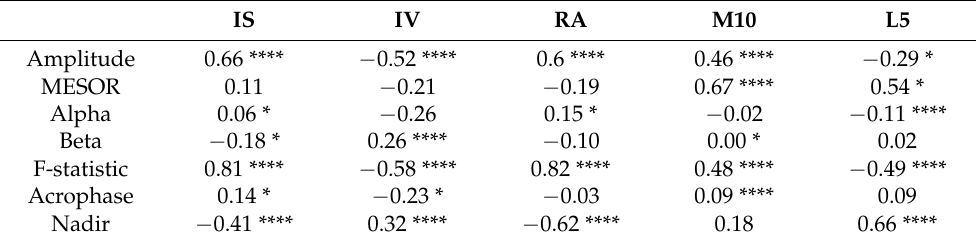
Table 3. Spearman correlation coefficients between non-parametric and parametric RAR indicators at baseline.